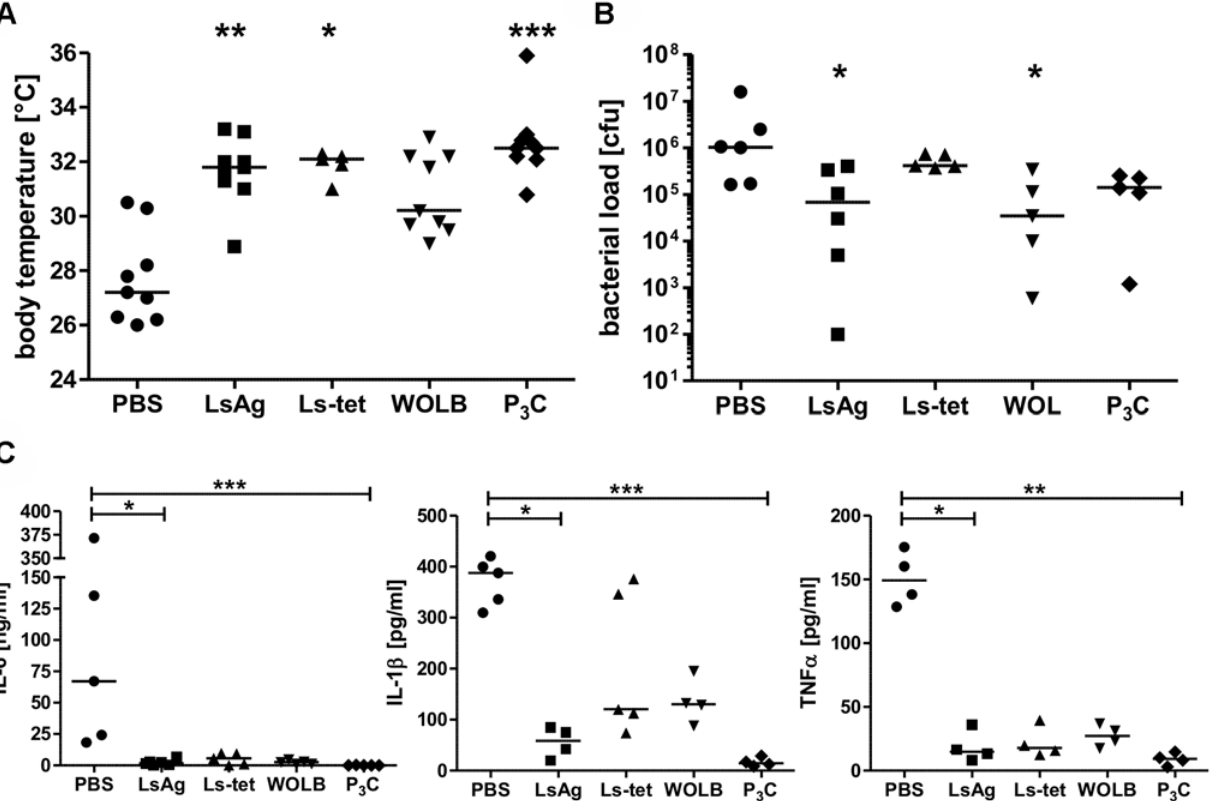
Figure 8. Repeated injections of Wolbachia -containing preparations and TLR2 ligands improve subsequent E. coli -induced sepsis in vivo . Mice were injected three times with 40 µ g of L. sigmodontis extract (LsAg), L. sigmodontis extract obtained from tetracycline treated worms (Ls-tet), Wolbachia (WOLB) or Pam 3 Cys (P 3 C) every fourth day. Two days after the last injection sepsis was induced by i.p. E. coli injection. Body temperature ( A ), bacterial loads ( B ) and serum IL-6, IL-1 β , and TNF α levels ( C ) were monitored six hours after E. coli challenge. Data in ( A-C ) is depicted as median and was tested for statistical significances using Kruskal-Wallis followed by Dunn ’ s multiple comparisons test. * p < 0.05;. ** p < 0.01; *** p <